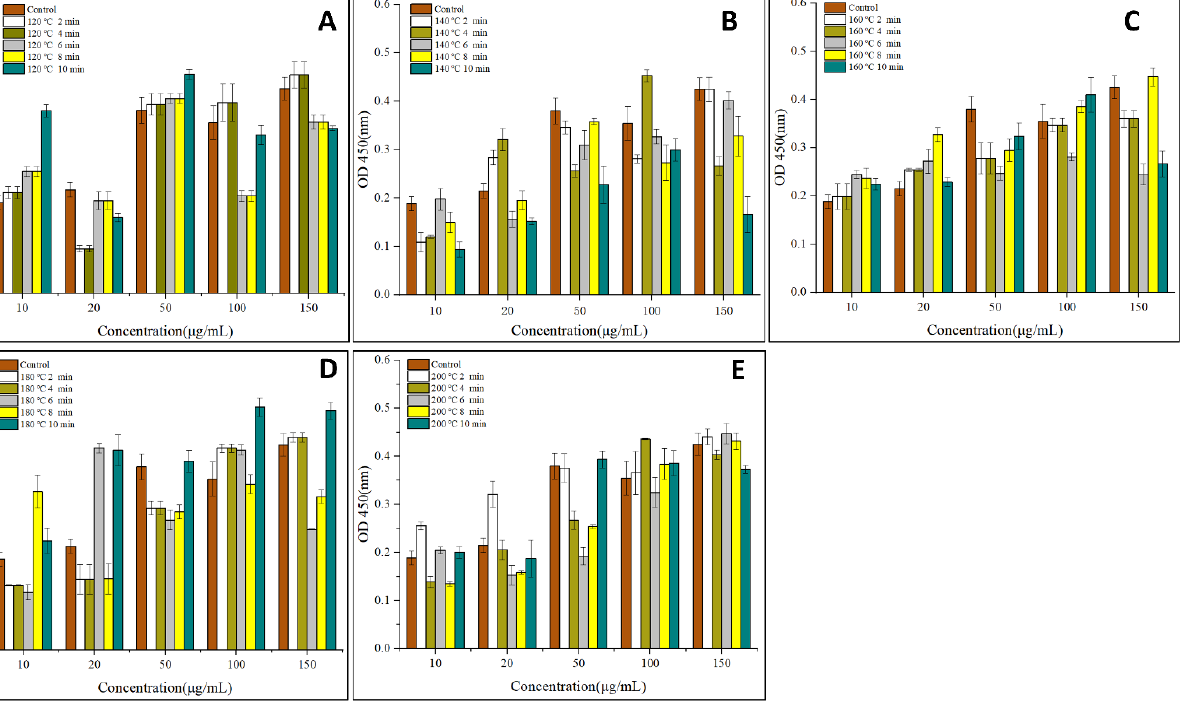
Figure 2. Effects of SS-treated OVM at different temperatures and times on the cell viability ( A – E ) of the KU812 cells sensitized with sera IgE from patients allergic to